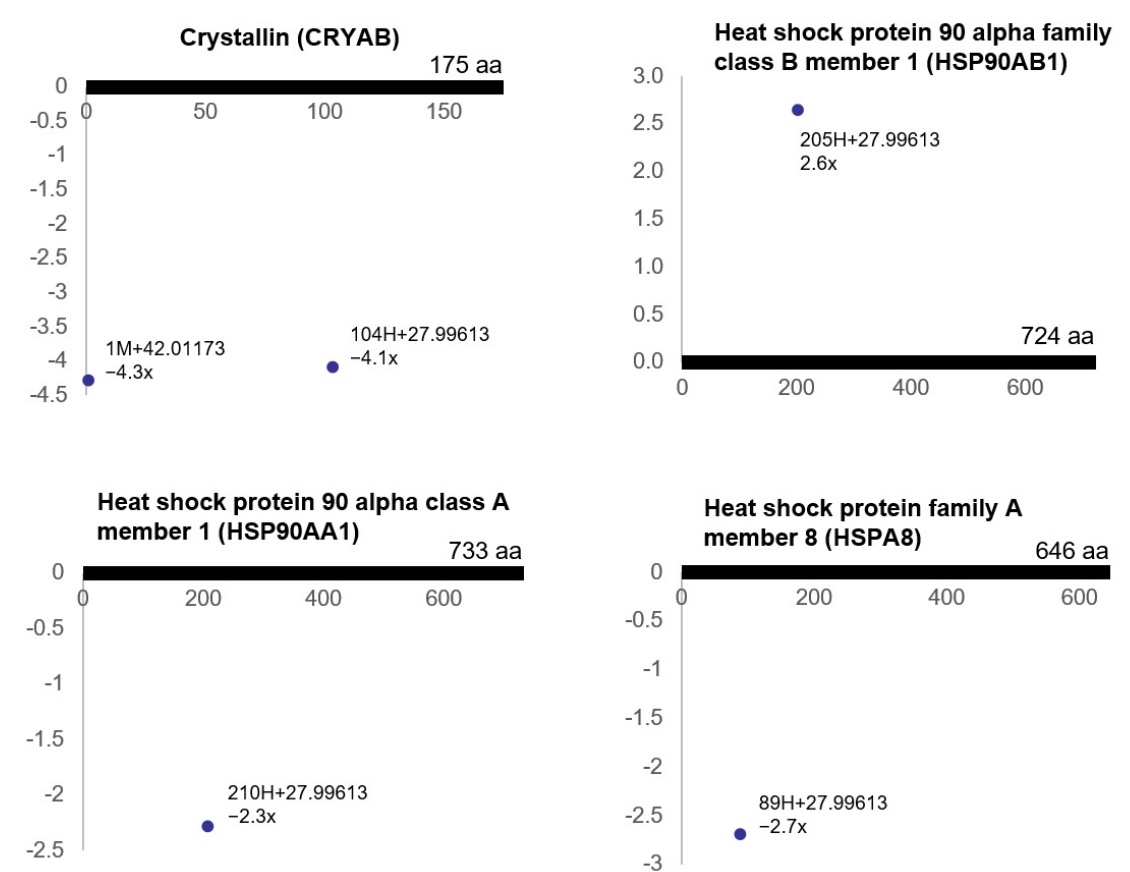
Figure 2. The modified residues of the proteins involved in HSF1-dependent transactivation (R 2 > 0.5, ratio > 2, p < 0.05). Each dot represents an ncAA of each protein. The annotation information of each dot is as follows: modified (protein) position, modified amino acid residue, delta mass and ratio of modification. The horizontal axis represents the amino acid position of each protein; The vertical axis represents the ratio of modification (up or down). The possible modification for each nonzero delta mass is as follows: 42.01173: acetylation, S > E; 27.99613: formylation, S > D, T > E.